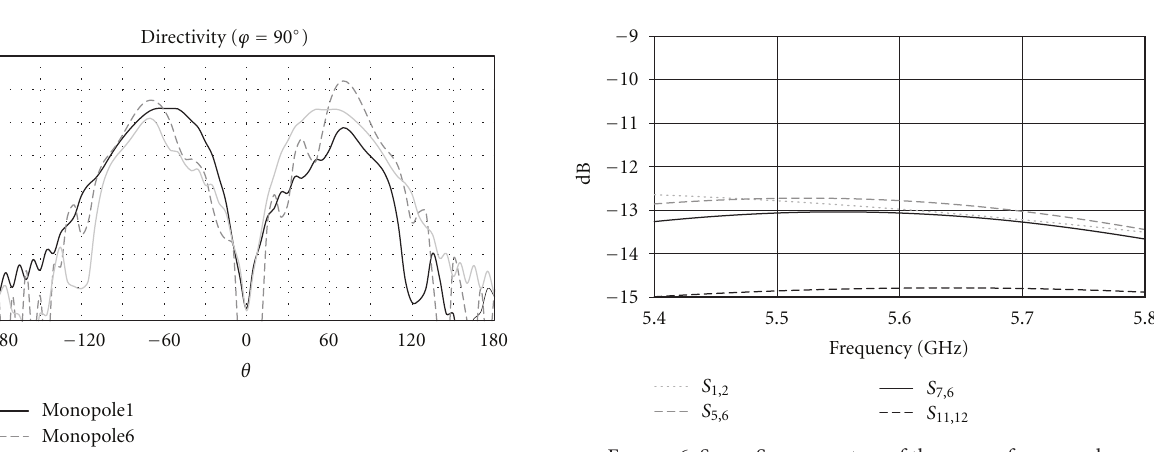
Figure 6: Some S ij parameters of the array of monopoles.